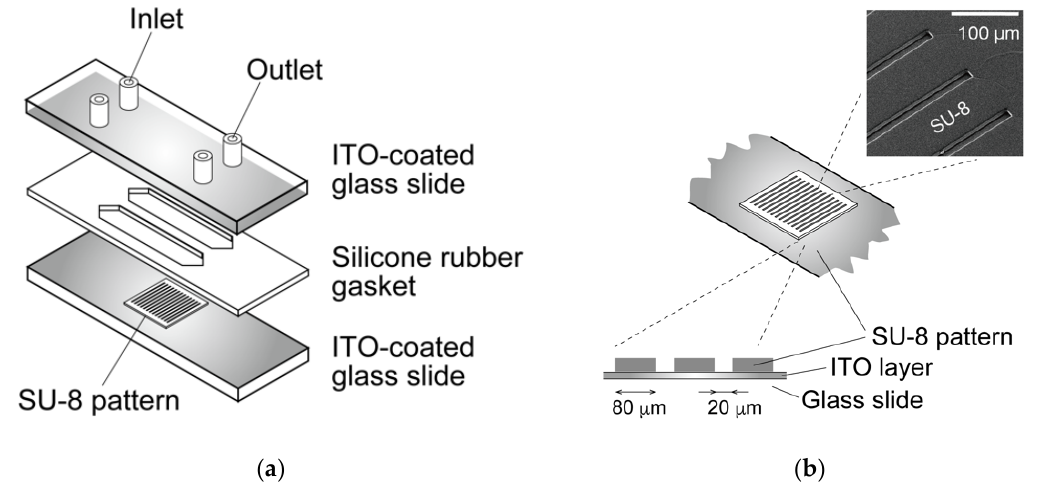
Figure 1. Schematic of the dielectrophoretic chamber. ( a ) The chamber was constructed by sandwiching a silicone rubber gasket between two glass slides coated with indium tin oxide (ITO). ( b ) The bottom slide was partially insulated by an SU-8 pattern to fabricate a parallel-line electrode array.